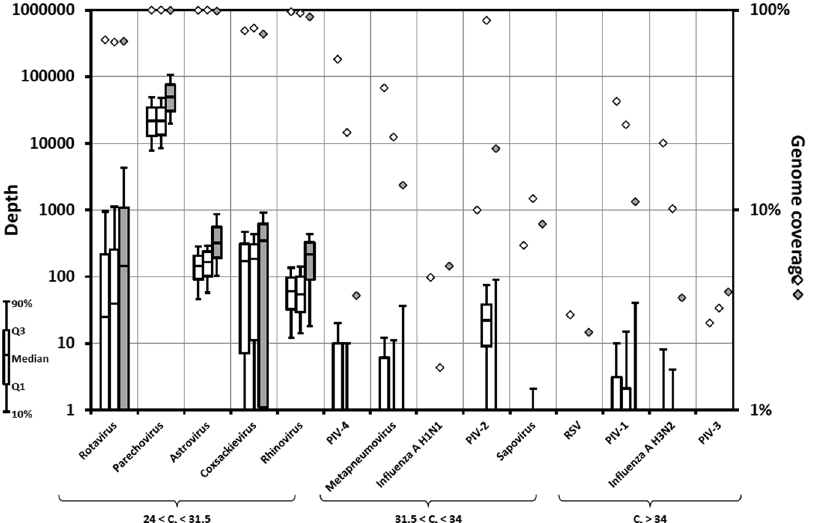
Figure 2. Relationship between viral load, sequencing depth and genome coverage. Analysis of genome coverage (diamonds) and sequencing depth (box-and-whisker plots) for each of the 14 Virus Multiplex Reference Panel viruses analysed. Symbols for the plasma-diluted samples are open and those for the PBS- diluted Panel data are shaded. Viruses have been stratified into three groups by reported C q values 42